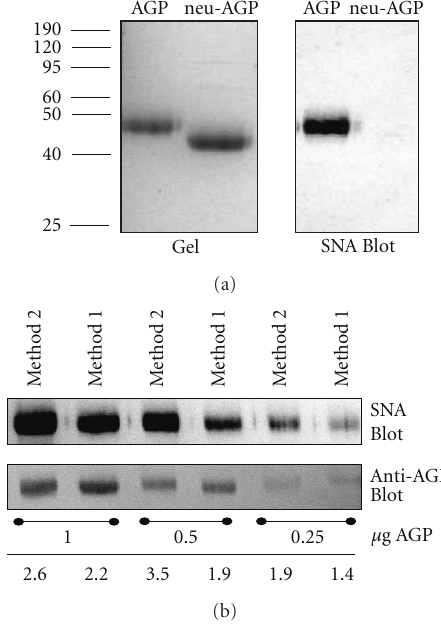
Figure 2: Reaction of AGP with neuraminidase and reaction of Method 1 versus Method 2 AGP with lectins and antibodies. AGP purified by Method 2 (AGP; 2 μ g total protein/lane) was treated with or without neuraminidase (neu-AGP) and examined on SDS reducing gels or replica SNA blots (a). Molecular mass markers (in kDa) are shown at left. (b) shows 0.25–1.0 μ g AGP from Methods 1 or 2 on blots probed either with Sambucus nigra agglutinin (SNA Blot) or with Anti-AGP antibodies. The SNA: anti-AGP ratio of the band intensities is shown beneath the